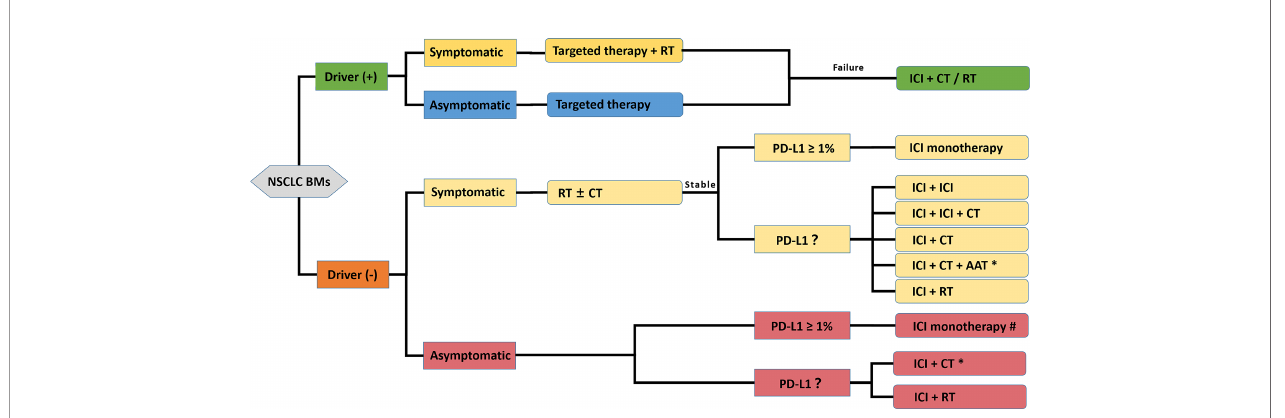
FIGURE 3 | A propositional management algorithm for NSCLC patients with BMs who are candidates for ICI-containing comprehensive treatment. This algorithm considers patients who are candidates for an ICI-containing comprehensive therapy after the standard patient examination and tumor specimen evaluation (driver- gene status and PD-L1 expression evaluation). Targeted reagent-centered therapy should be recommended fi rst for driver-positive patients owing to a favorable intracranial response rate. Considering the poor prognosis of BMs, ICI monotherapy is recommended with more caution, and ICI-containing combination therapy is encouraged. ICI Patients with symptomatic or multiple BMs could be treated with RT strategies. The fi nal therapeutic decision should be made by a multidisciplinary tumor board. * only appropriate for nonsquamous NSCLC; # optimal when PD-L1 ≥ 50%; ICI, Immune Checkpoint Inhibitor; CT, Chemotherapy; RT, Radiotherapy; TT, Targeted therapy; AAT, Anti-angiogenic